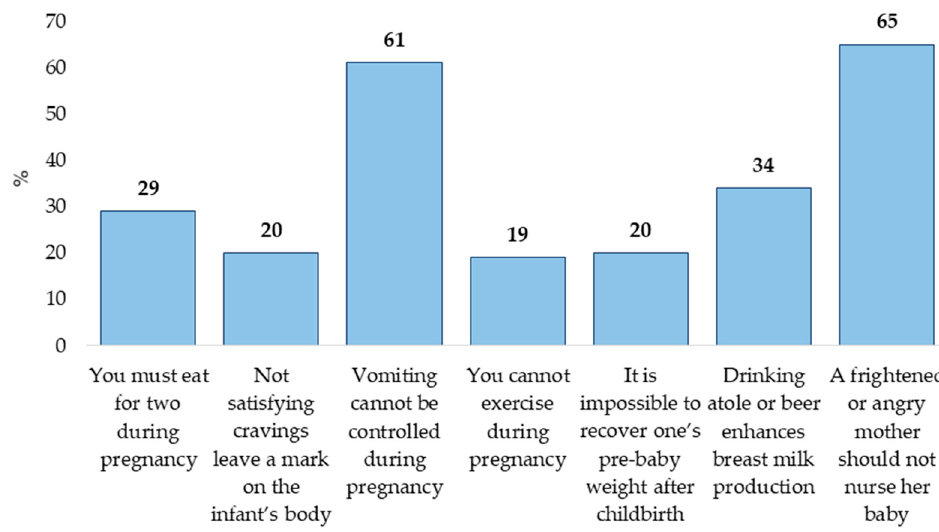
Figure 2. Distribution of participants that held myths.